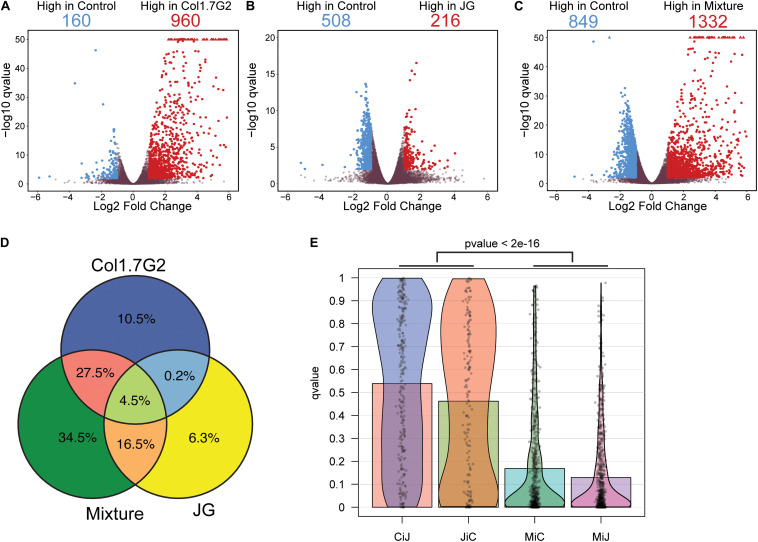
Comparative analysis of mouse gene expression after exposure to single and mixed T. cruzi infections. Volcano plot of (A) Col1. 7G2-, (B) JG- and (C) mixture-infected groups showing the log2 fold changes for each detected gene on the x-axis along with the -log10 adjusted p-values after comparison with non-infected controls on the y-axis. Blue colored dots represent significant genes with a log2 fold change < -1 while red colored dots represent significant genes with a log2 fold change greater than 1. Gray dots represent genes that were not considered differentially expressed (D). The Venn diagram shows the proportions of shared and exclusive genes in each group (see Supplementary Table S3 for gene names). (E) Distribution of the adjusted p-values (qvalue) of exclusive DEGs from Col1.7G2 or JG-infected groups present in the non-significant gene list of JG (CiJ) and Col1.7G2-infected groups (JiC) respectively, as well as the distribution of exclusive DEGs from the Mixture found in the non-significant lists of Col1.7G2 (MiC) or JG (MiJ). The p-value < 2e-16 represent the comparison of MiC or MiJ against CiJ or JiC using the Wilcoxon rank sum test.